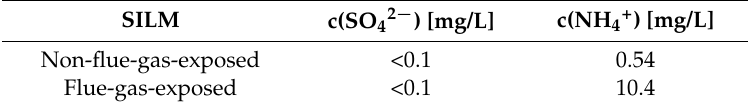
Table 9. Concentration of NH 4+ and SO 42 − in the membrane washing